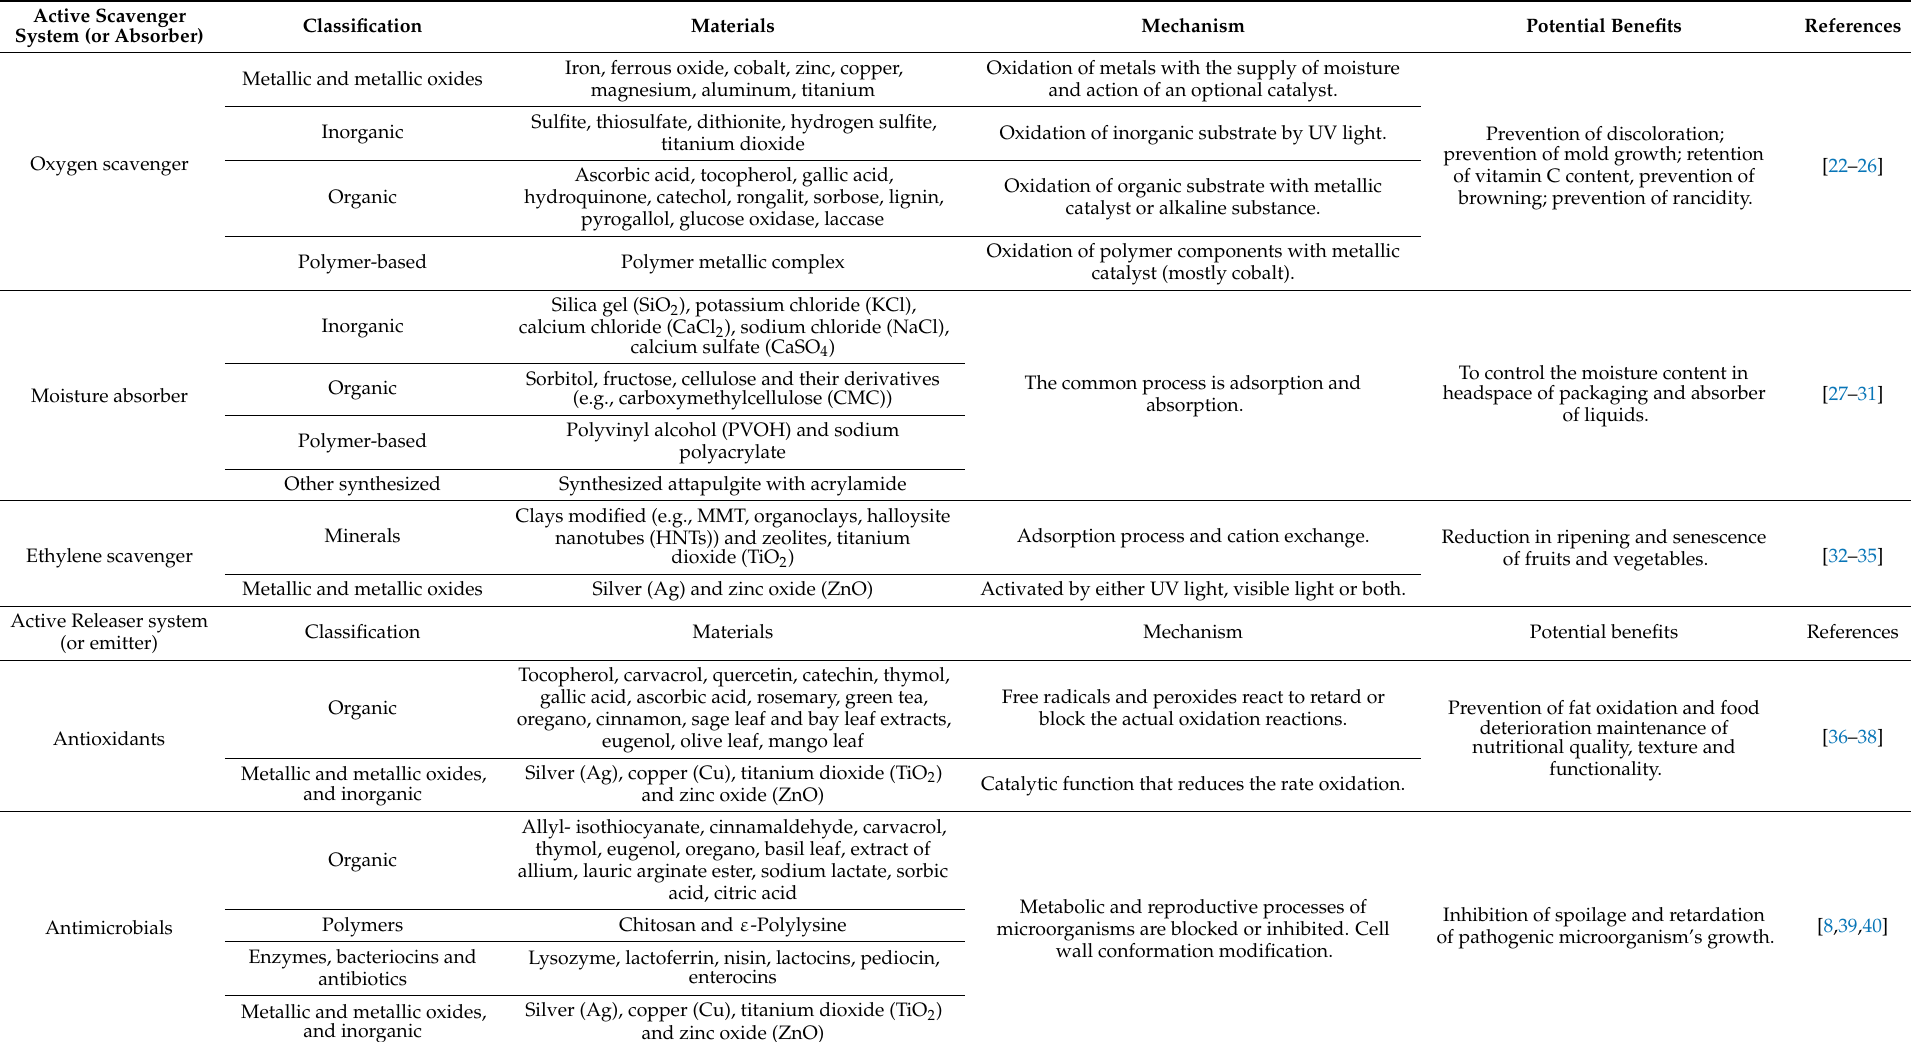
Table 1. Overview of active packaging technologies, active agents used, their mechanisms and potential benefits in food